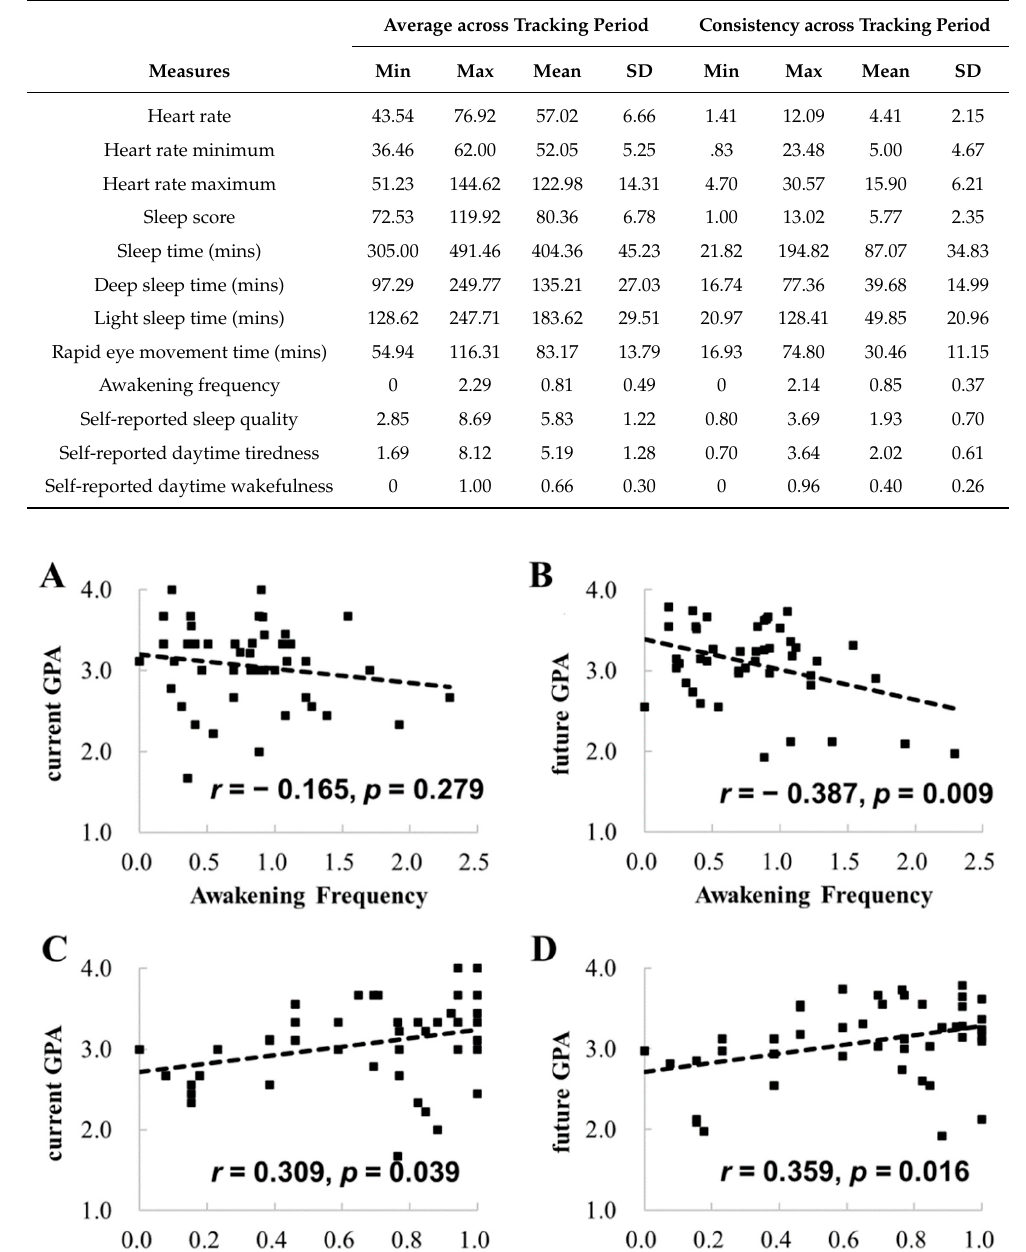
Table 1. Basic statistical results of average and consistency of sleep measures provided by the wearable device and self-reported measures.